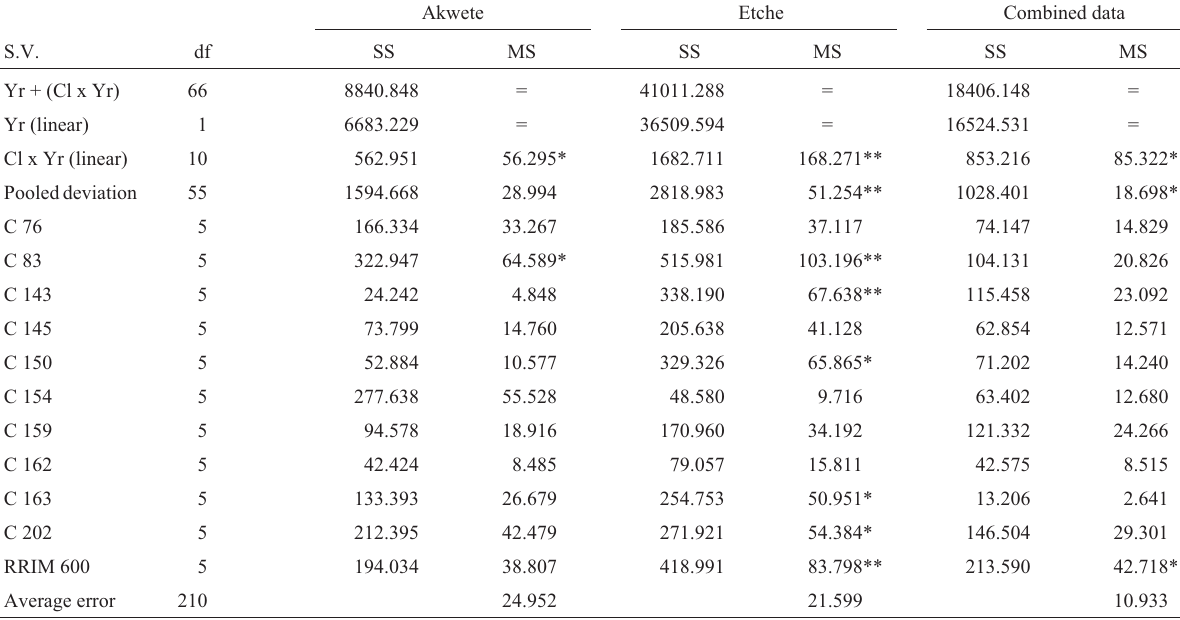
Akwete Etche Combined